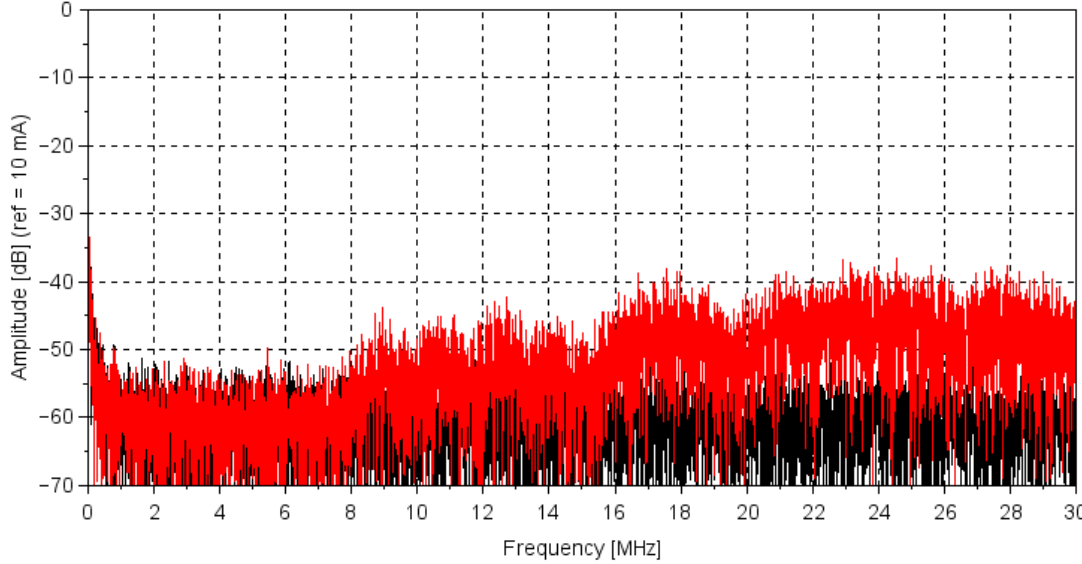
Figure 5. Figure showing the 100 kpts frequency spectra of signals with no arc (black) and with the arc (red).